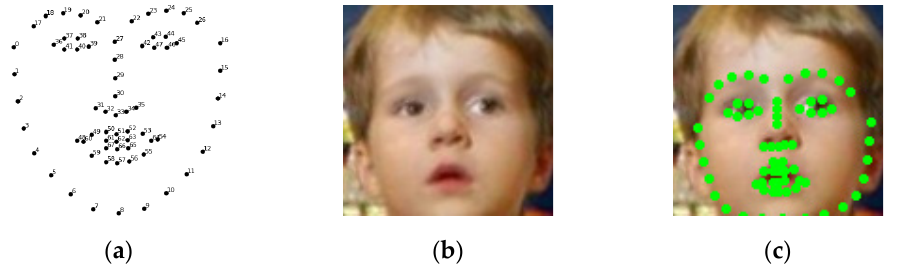
Figure 5. Schematic diagram of key point detection for human face. ( a ) Sixty-eight key points on a human face. ( b ) Face that needs to be matched. ( c ) Key points and face fitting.